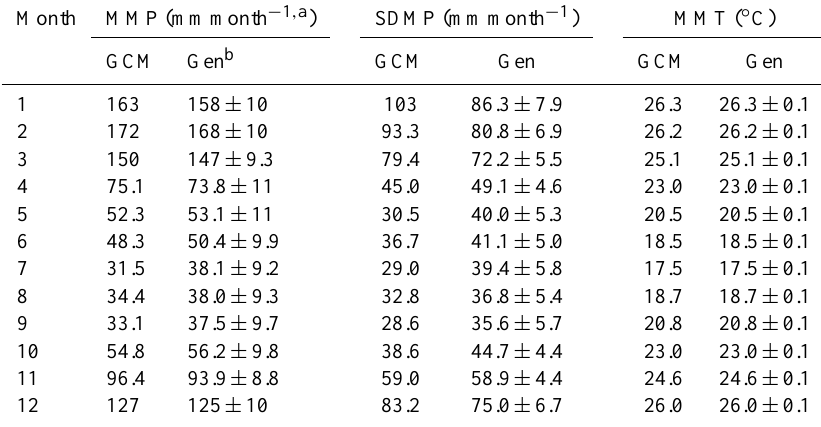
Table 2. Comparison between MIROCM(1) GCM estimates of mean and standard deviation of monthly precipitation and mean monthly temperature of 20C3M data and stochastically generated values for catchment 6304. Generated values are based on 100 replicates, each 151 years